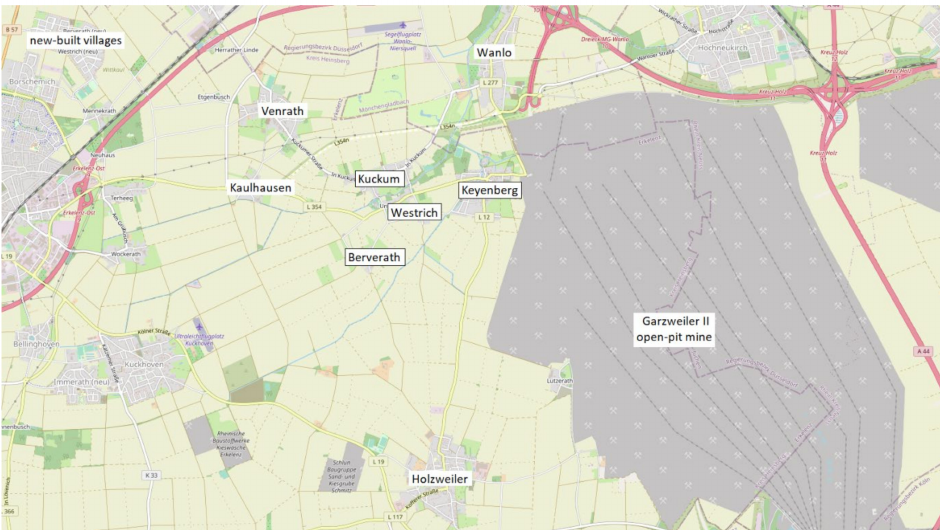
Figure 1. Garzweiler open-pit mine, with relevant surrounding old (framed), pit-edge and new-built villages. © OpenStreetMap contributors (CC BY-SA 2.0), edited by the